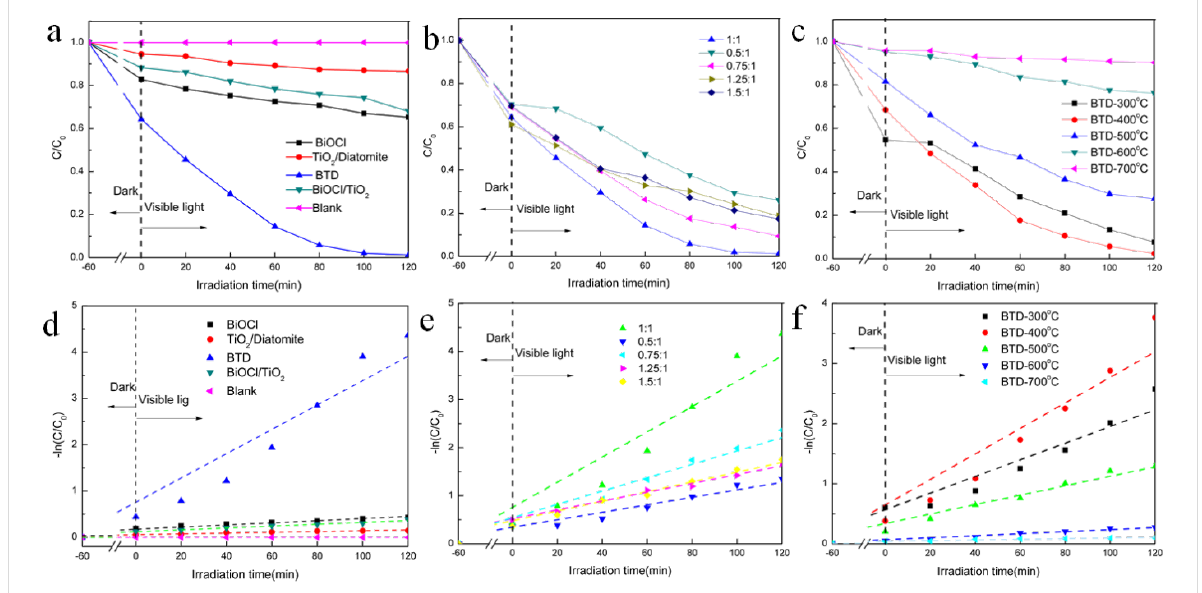
Figure 7: The photodegradation curves and corresponding kinetic plots of different samples, including various photocatalysts (a and d), BTD with dif- ferent molar ratios of BiOCl to TiO 2 (b and e), and BTD prepared with different calcination temperatures (c and f).